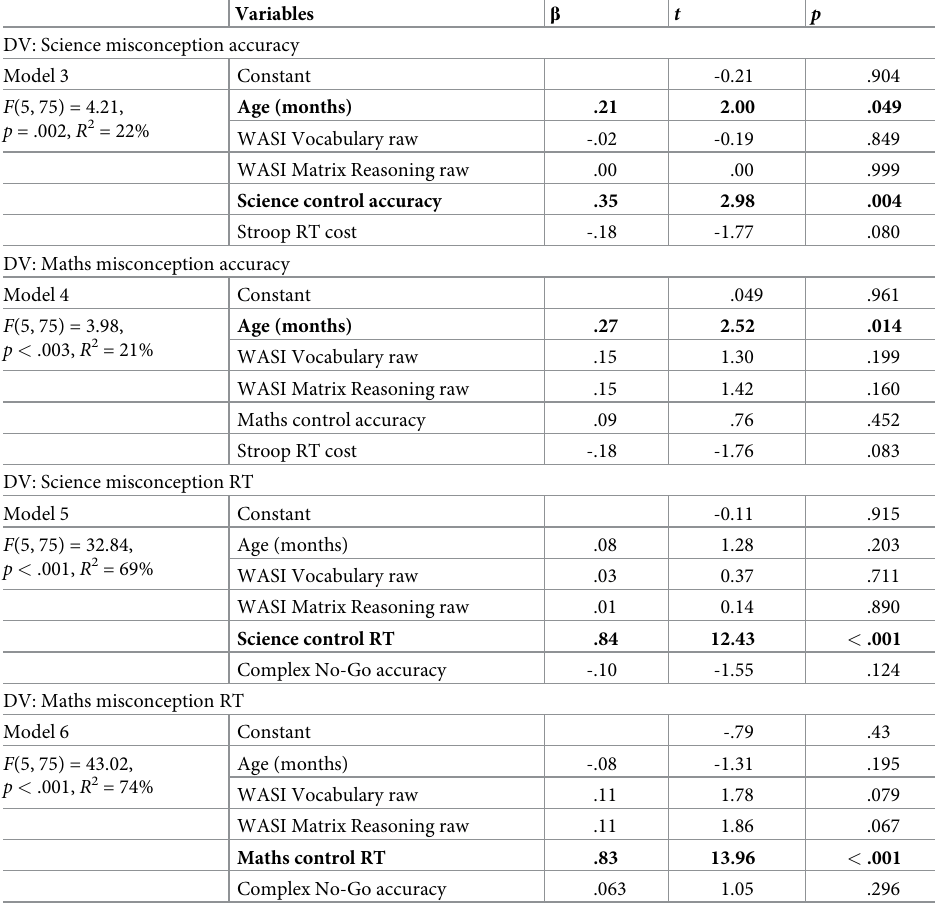
Table 5. Regression models for science and maths